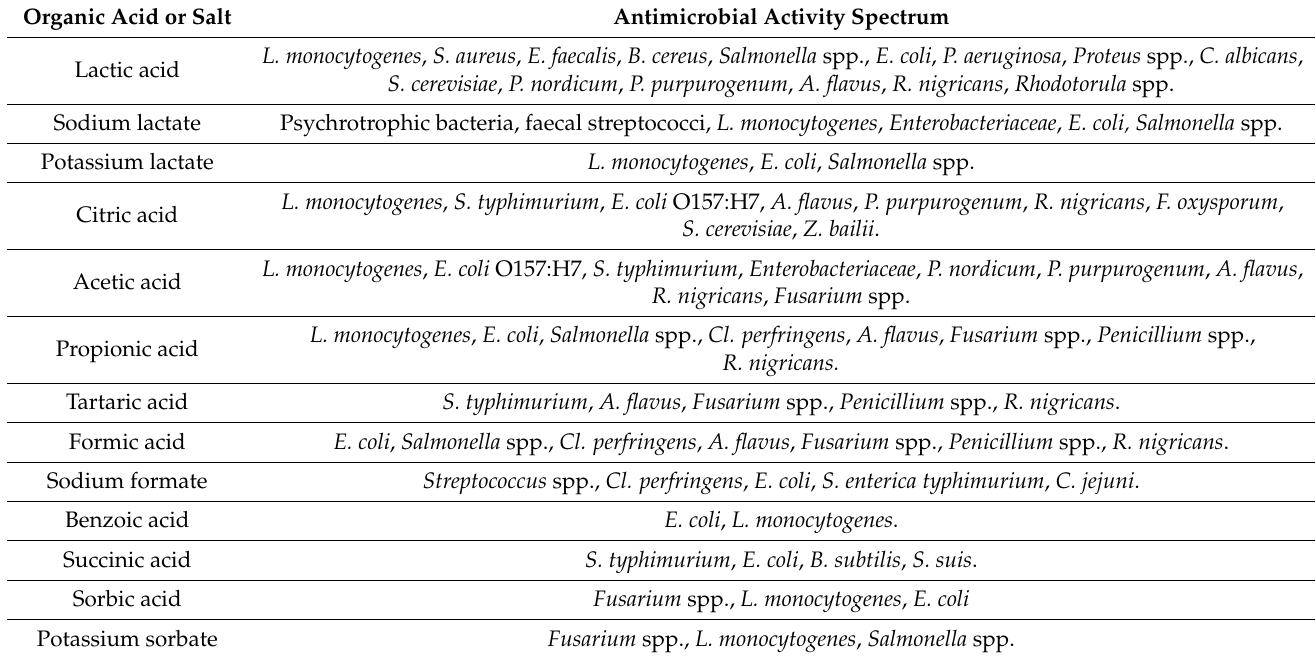
Table 1. Antimicrobial activity spectrum of organic acids and their